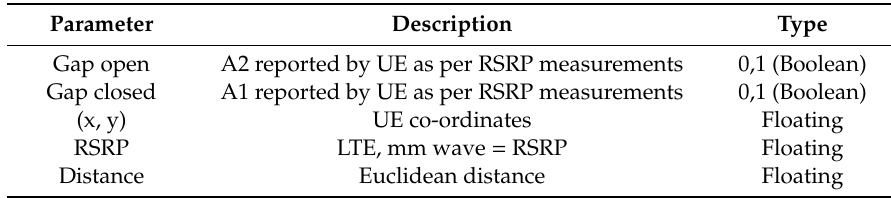
Table 3. Learning f